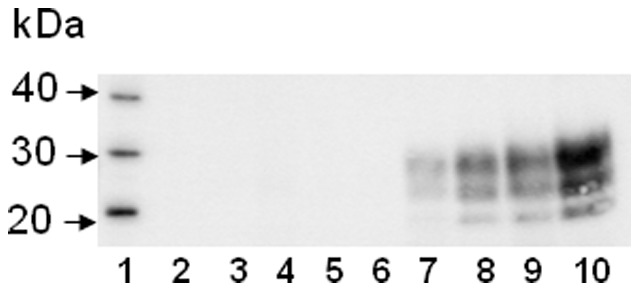
Detectable levels of PrPSc on Western blots do not correlate with the levels of infectivity.10% brain homogenates from an uninfected brain (lane 2) time-course samples week 3, 6, 9, 12, 15, 18, 21 (lane 3–9), and the terminal sample (lane 10) were digested with proteinase K at 60°C for 10 minutes and assessed by Western blot. The observed signal does not correspond with the levels of infectivity found in corresponding bioassays for the week 12–21 post-exposure time-points.